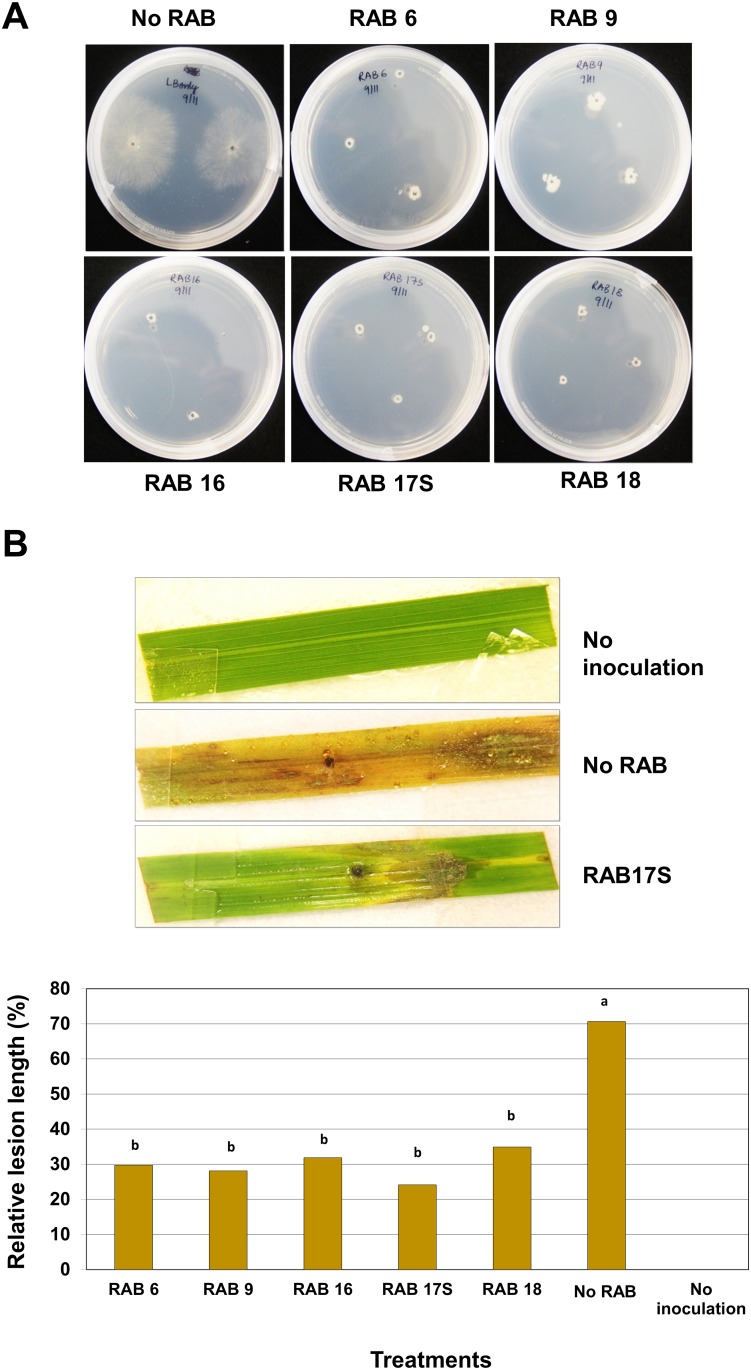
Inhibitory activities of antagonistic RABs on Rhizoctonia solani.(A) Inhibition of sclerotial germination by RABs. Overnight cultured sclerotia with RAB inoculum in test tube were grown on PDA media and incubated at 25°C for 72 h. Sclerotia cultured only in LB broth were used as control. Sclerotial germination was inhibited by all RABs inoculum except in the control where the mycelial growth can be observed. (B) Inhibition of sheath blight lesion development by pretreatment of RABs: Examples of detached leaf assay revealing inhibitory activities of RABs against lesion development by R. solani. A detached rice leaf pretreated with a RAB was placed on paper towel moisturized with sterilized ddH2O and a sclerotium of R. solani was inoculated on the center of the detached leaf. Petri-dishes containing the inoculated rice leaves were incubated at 25°C for 7 d with 12 h of light period per day (upper); and Inhibition of sheath blight lesion development by the five selected RABs that showed highest antifungal activities in the dual-culture assay (lower). Each column of the graph represents the average of three replications and the letter above each column indicates significant difference with P < 0.05, which was determined by Tukey’s test.